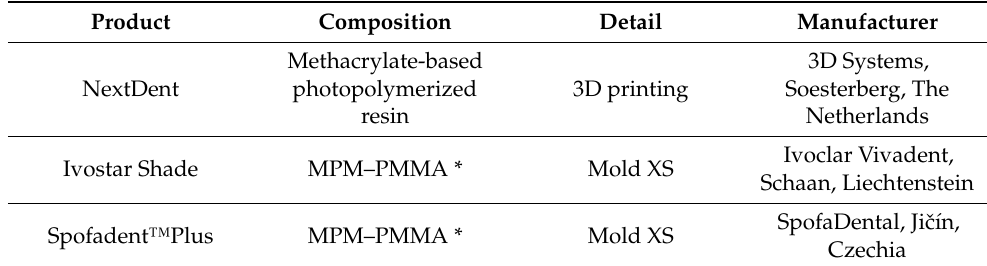
Table 1. Types of denture teeth used in this study. Product Composition Detail Manufacturer Methacrylate-based 3D Systems, NextDent photopolymerized 3D printing resin Ivoclar Vivadent, Ivostar Shade MPM–PMMA * Mold XS Spofadent™Plus Mold XS